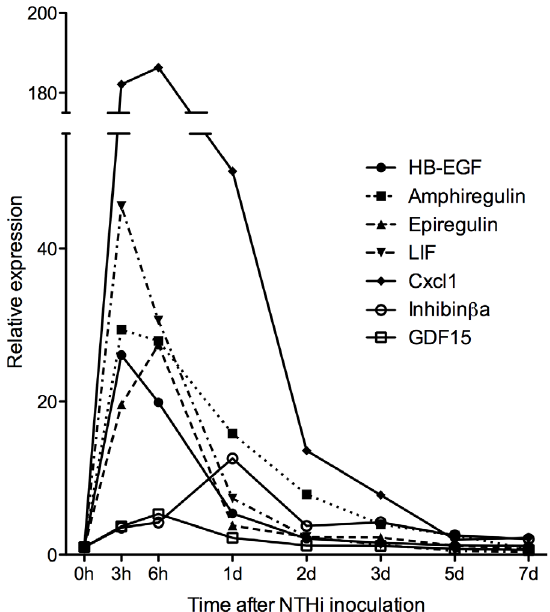
Figure 1. Expression of mRNA encoding growth factors identified for their potential to influence ME mucosal hyper- plasia, based on the kinetics of upregulation in excess of 5- fold, assessed by gene array in the mouse ME during NTHi- induced acute OM. Data are expressed as relative increase over untreated ME mucosa (0 h). Details of variability and statistical signficance are provided in Table S1.